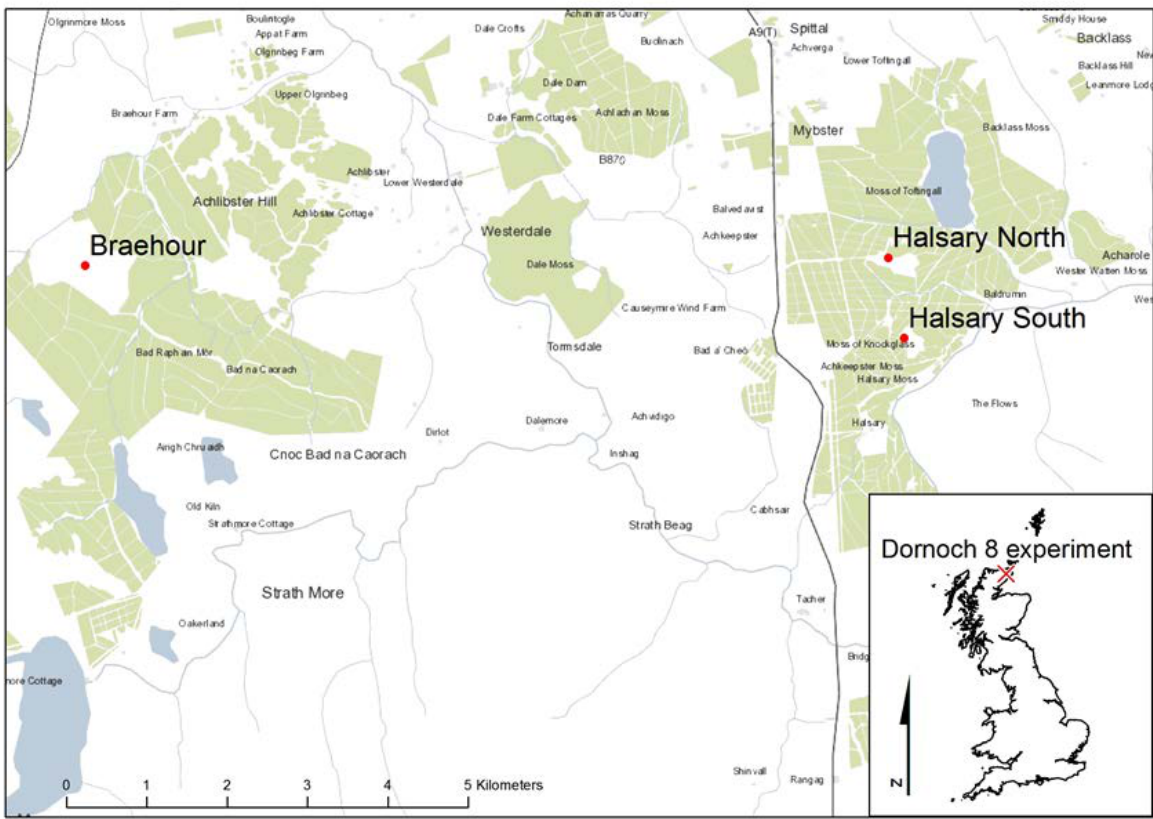
Figure 1. Locations of the experiment (red cross on inset map) and its three sites (red dots on main map). October and December 1996. Two blocks